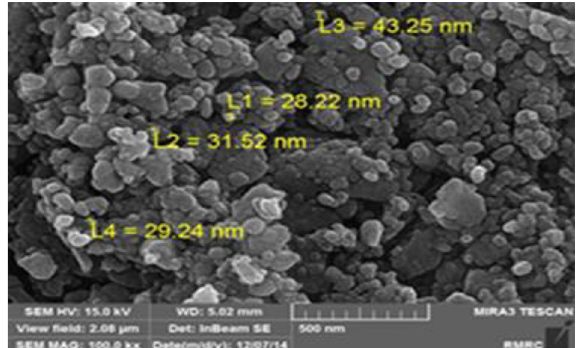
Figure 4. SEM image of the ball-milled seashells nano-biocomposite ( 3 ).